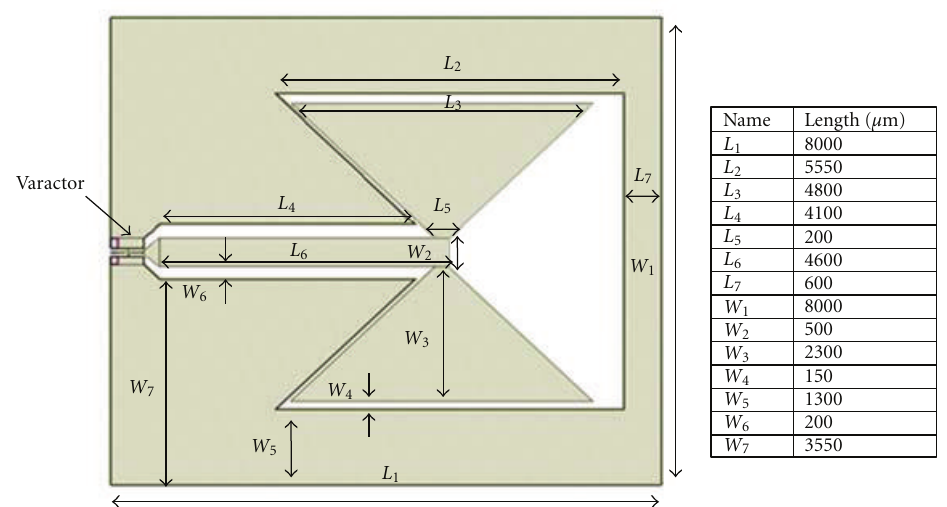
Figure 3: A CPW-Fed bowtie slot antenna connected with a BST thin-film varactor.